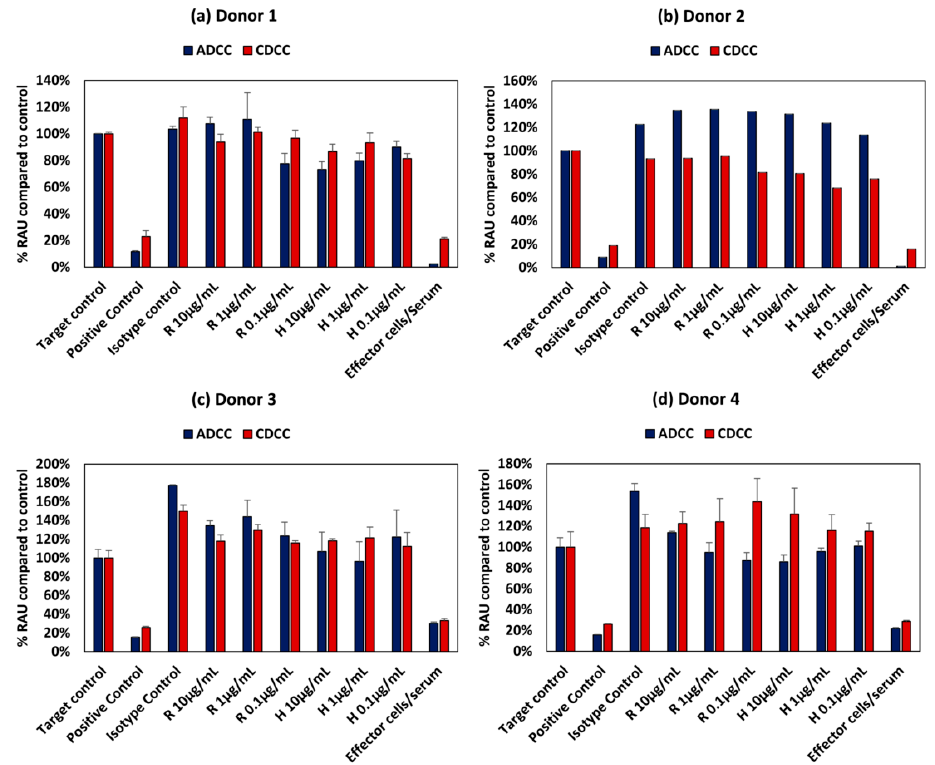
Figure 5. Intrinsic variation in responses owing to donor variability in ADCC and CDCC assay results of rituximab and Trastuzumab based on the ATP content compared to control in HepG2 cells exposed to mAbs for ( a ) Donor 1, ( b ) Donor 2, ( c ) Donor 3 and ( d ) Donor 4 All values expressed as relative Absorbance Units (RAU) compared to control (mean ± SE). R: Rituximab and H: Trastuzumab. Positive control is 5% ( v / v ) of absolute ethanol.